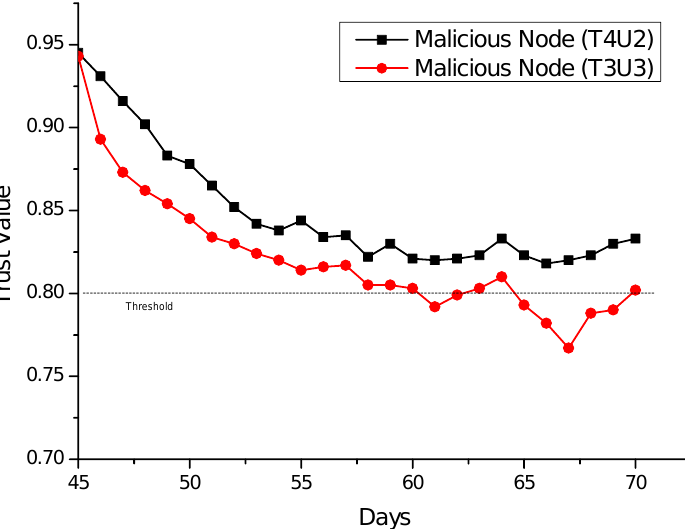
Figure 5. Trust values of malicious node (e.g., node D) calculated by target node (e.g., node A) under Scenario